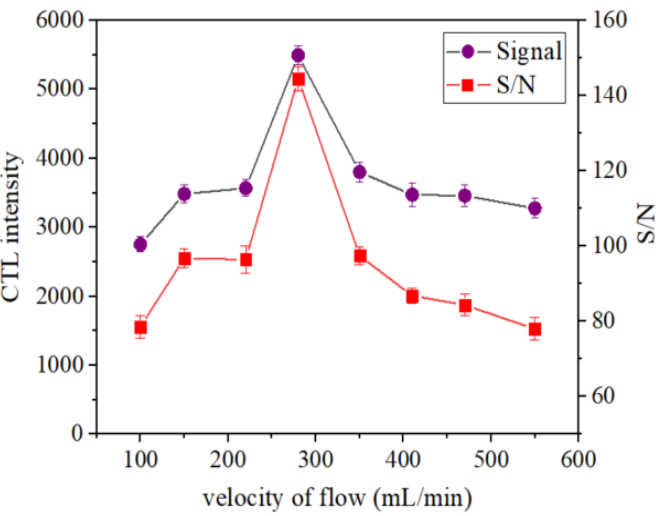
Figure 8. Effect of flow rate on CTL intensity and S/N (concentration: 33.75 ppm; temperature: 162 ° C).